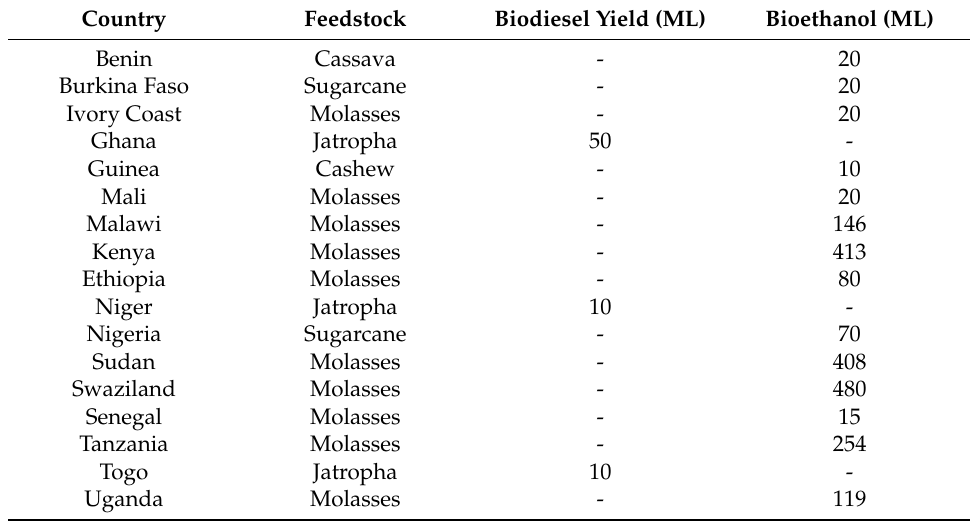
Table 1. Biofuel production from agricultural waste in Sub-Saharan African countries [10]. Country Feedstock Biodiesel Yield (ML) Bioethanol (ML) Benin Cassava